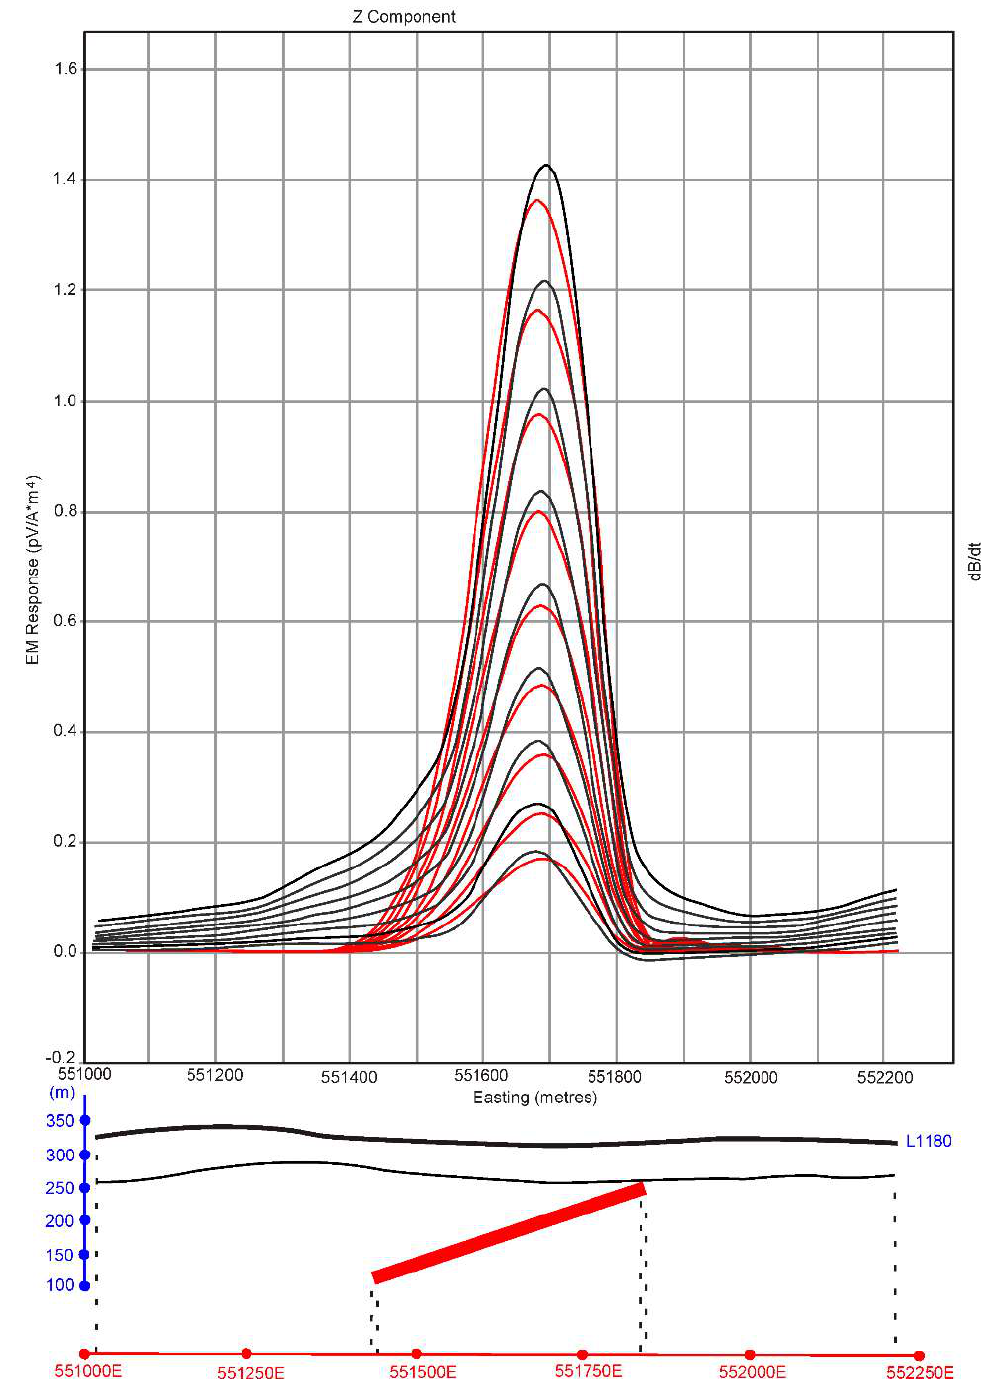
Figure 11. Maxwell thick plate modelling of the L1180, T-2 target, facing north. The black lines are the field data of the Z component of the VTEM flight line L1180 and the red lines indicate the signals from the modelled plate. The top of the modelled conductor is close to surface and dips 20° west, with a conductance 81S.